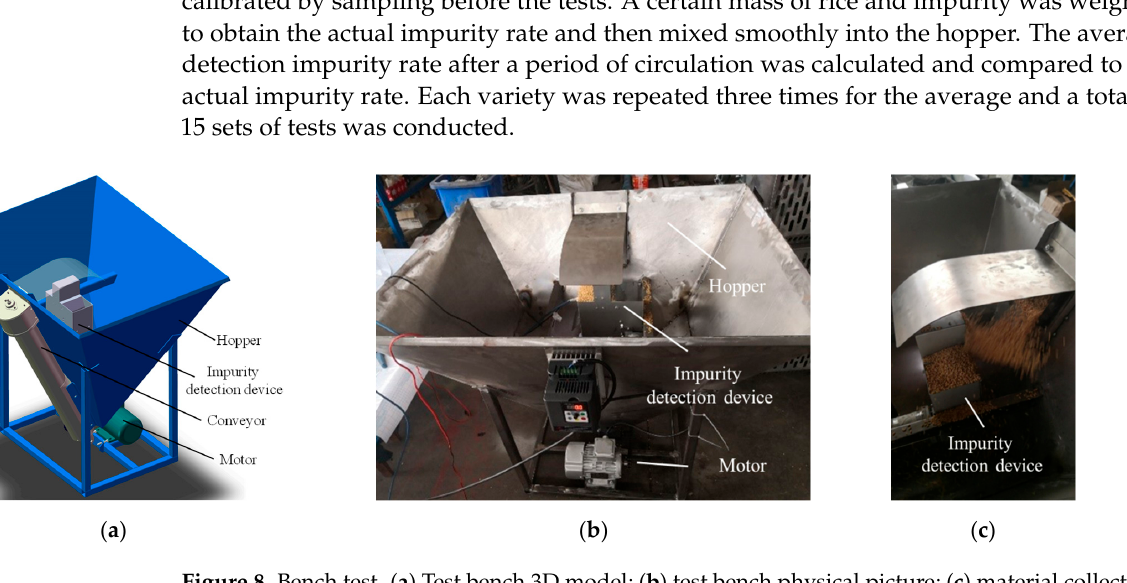
Figure 7. Material pixel density calibration test. ( a ) Calibration device; ( b ) calibration image; ( c ) bi- narized image.